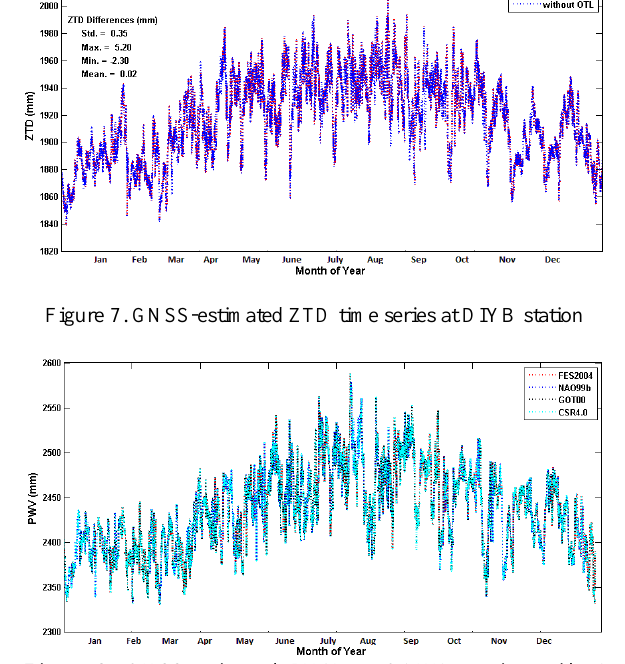
Figure 8. GNSS-estimated PWV at GANM station with 4 different tide